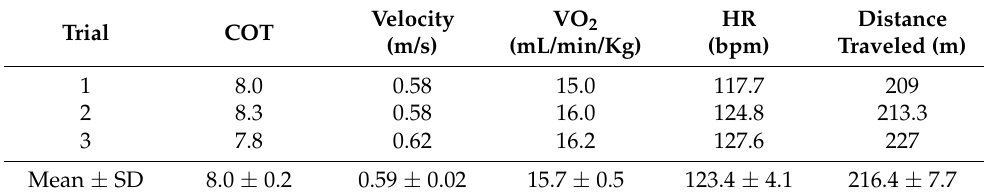
Table 7. Metabolic cost estimation following the 6 min walking test wearing KAEGO with 100% rated